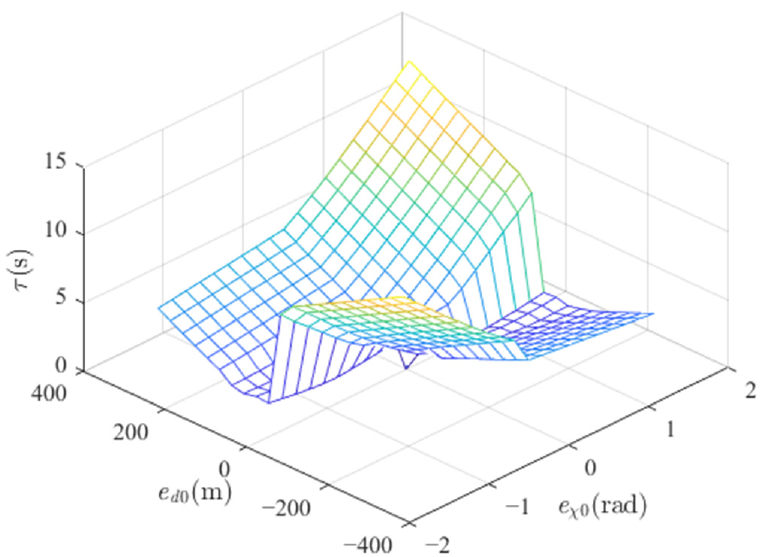
Figure 6. The relationship between the time constant τ and the initial states of e d 0 and e χ 0